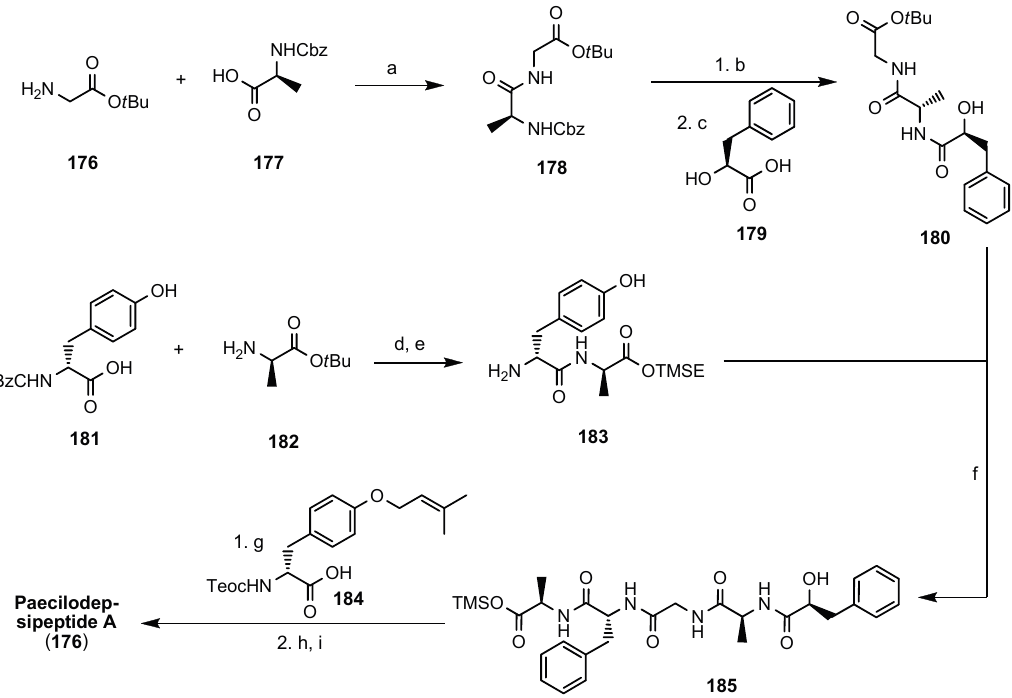
Scheme 10. Total synthesis of paecilodepsipeptide A